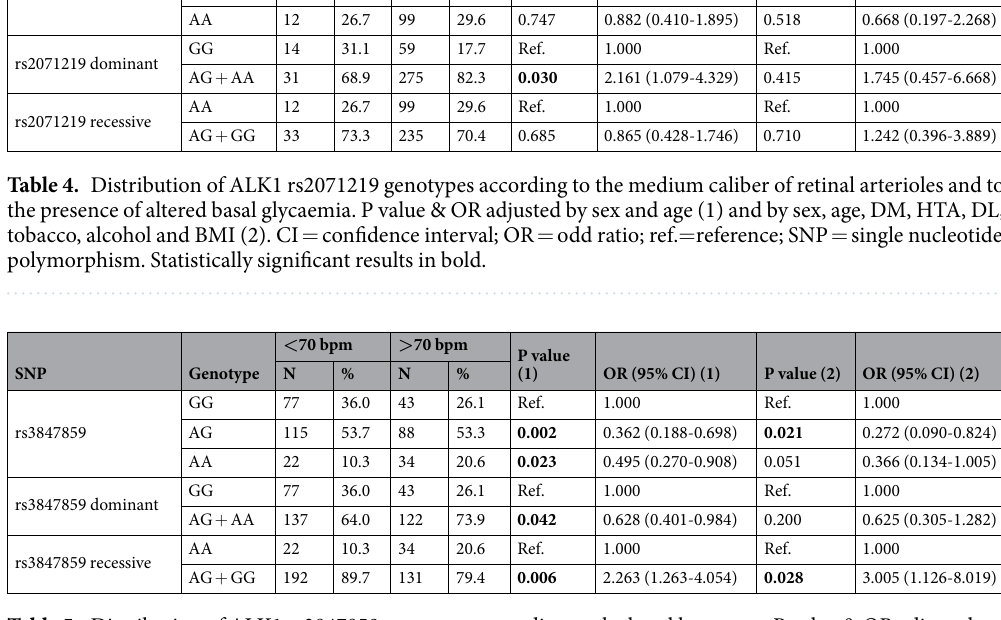
Table 5. Distribution of ALK1 rs3847859 genotypes according to the basal heart rate. P value & OR adjusted by sex and age (1) and by sex, age, DM, HTA, DL, tobacco, alcohol and BMI (2). Bpm: beats per minute; CI = confidence interval; OR = odd ratio; ref. = reference; SNP = single nucleotide polymorphism. Statistically significant results in